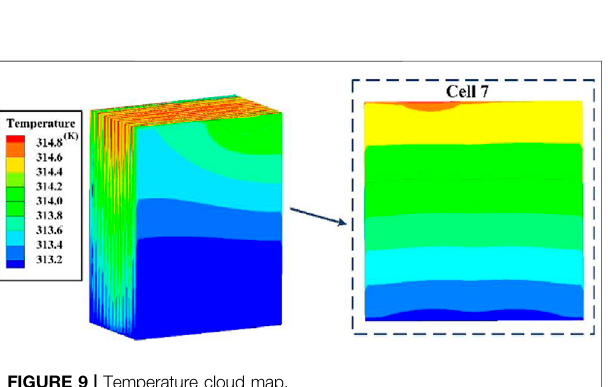
Frontiers in Energy Research |